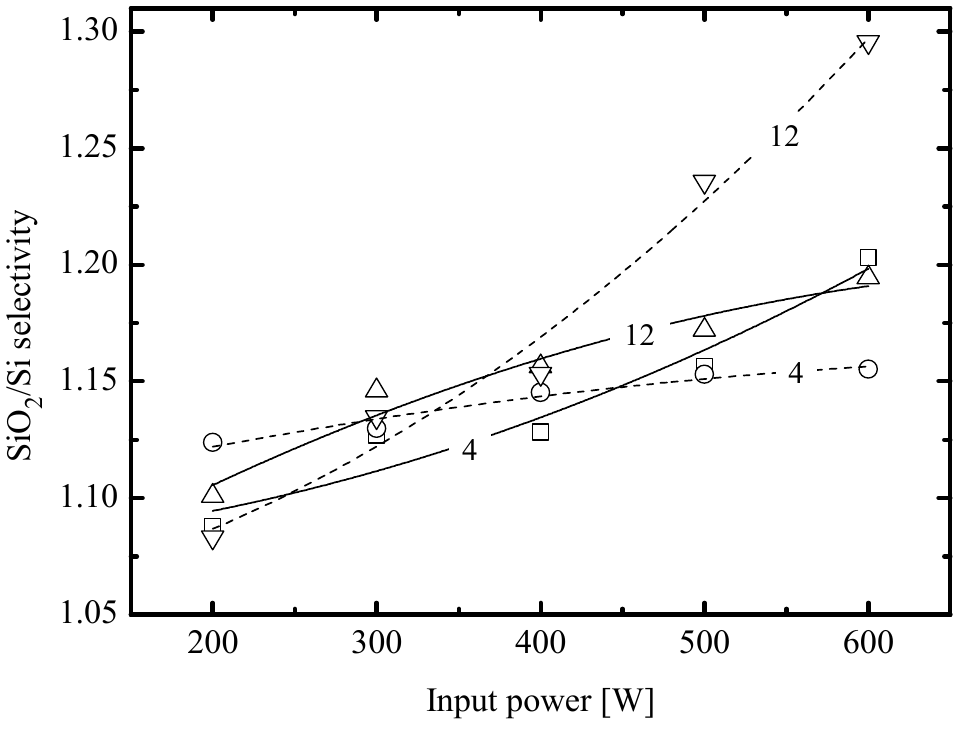
Figure 7. SiO /Si etching selectivity in 50% C Figure 7. SiO 2 /Si etching selectivity in 50% C 6 F 12 O + 50% Ar (solid lines) and 50% CF 4 + 50% Ar 2 (dashed lines) plasmas. Numerical labels on curves mean the gas pressure in (dashed lines) plasmas. Numerical labels on curves mean the gas pressure in mTorr.